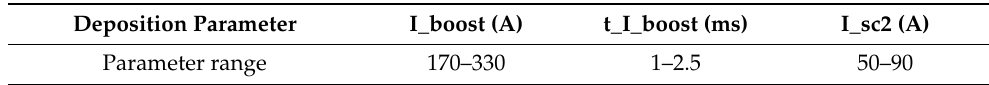
Figure 10. Electrical waveforms and droplet transfer process at ( a ) I_sc2 = 20 A and ( b ) I_sc2 = 100 A. Table 4. Range of the CMT characteristic